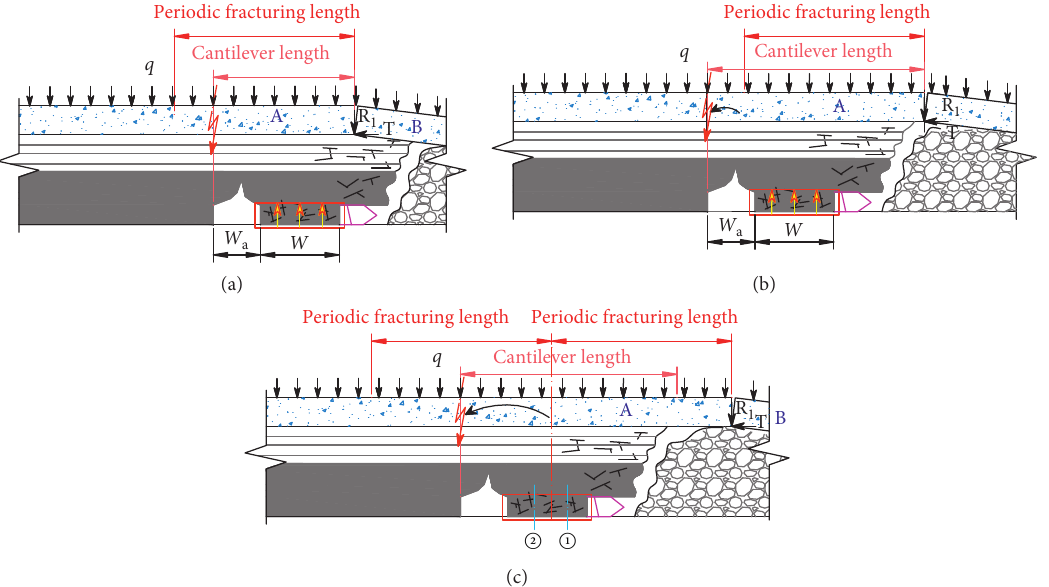
Figure 11: The relative position relation between the abandoned roadway and fracture position. (a) Fracture of the main roof (type i); (b) fracture of the main roof (type ii); (c) fracture of the main roof (type